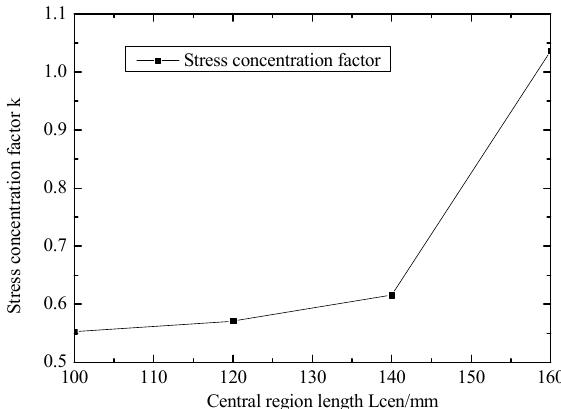
Figure 5. E ff ect of central region length on stress concentration